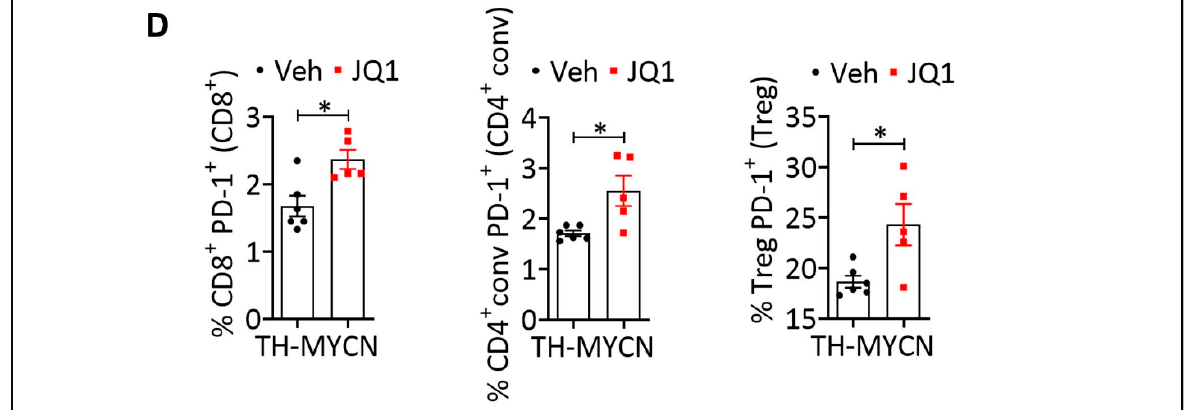
Figure 3. Immune phenotyping of JQ1-treated TH-MYCN tumors. ( A ) Experimental design of JQ1 treatment of TH-MYCN tumor-bearing mice showing the schedule and dosing. Following the development of homozygote TH-MYCN tumors, the tumor volume was assessed by MRI in all mice. Mice were randomly assigned to a vehicle-treated group ( n = 6) or a JQ1-treated group ( n = 5). Mice were treated three times with vehicle or JQ1 (25 mg/kg) by IP on days 1, 2, and 3. On day 4 post-treatment, MRI was performed to determine the tumor volume, and tumors were harvested for immune phenotyping experiments. ( B – D ) Flow cytometry quantification of total ( B ), CD69 + ( C ), or PD-1 + ( D ) CD8 + T cells, conventional (Conv.) CD4 + T cells and Tregs infiltrating vehicle-treated or JQ-1-treated TH-MYCN tumors at day 4. The defined subpopulations were gated and quantified in live CD45 + cells. Each dot represents one tumor. The data are reported as the average of six or five mice per group. Results are shown as mean ± SEM (error bars). Statistically significant differences (indicated by asterisks) are calculated compared to vehicle-treated tumors using an unpaired two-tailed Student’s t -test (ns: not significant *: p <